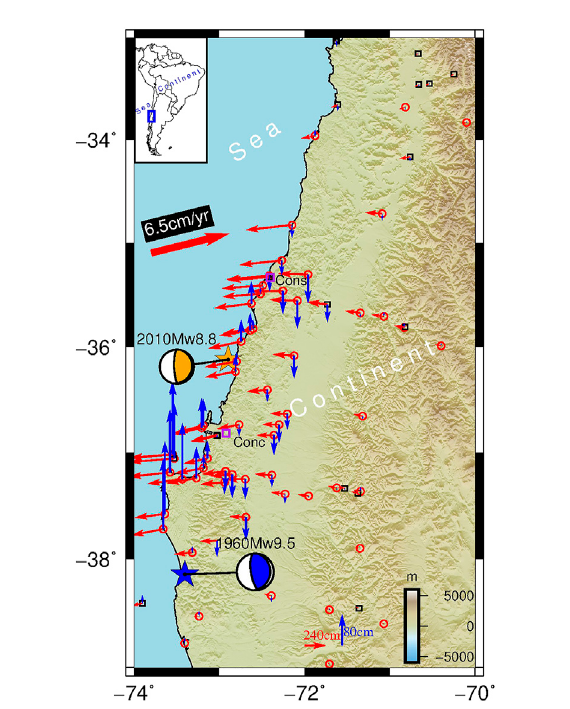
Thetectonic settingofthe2010 Maule earthquake. Theblack rectangle represents the continuous GPS stations, and the red circles are campaign stations. The red and blue vectors represent the horizontal and vertical displacements of GPS, respectively. The orange and blue stars are the epicenters of 2010 and 1960 earthquakes, respectively. The orange beach ball is the United States Geological Survey (USGS) centroid moment tensor. The focal mechanism of the blue beach ball is from Fujii and Satake (2013). The bold red arrow shows the interseismic convergence vector between the Nazca plate and the South American plate. The purple rectangles represent the locations of surrounding cities; Cons, Constitución; Conc,